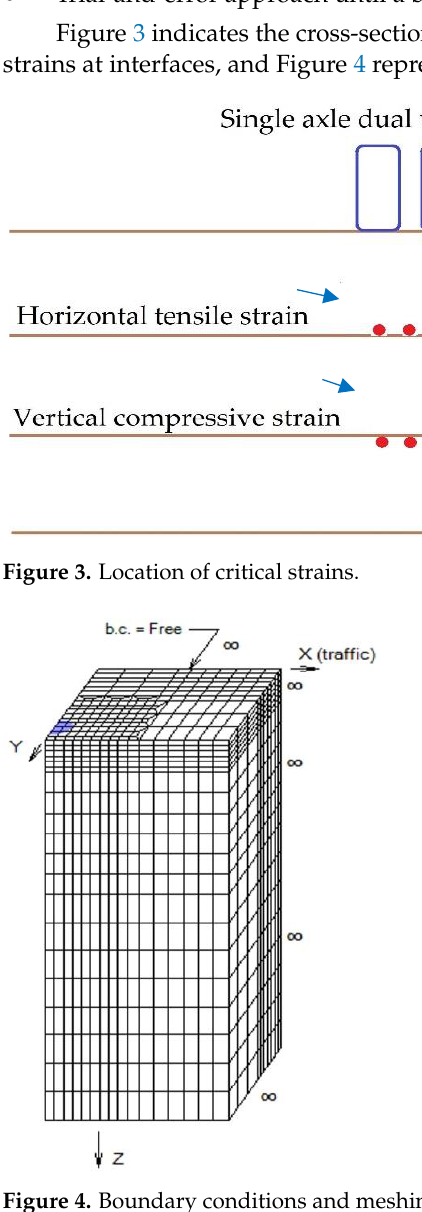
5 of 18 for the design. The wide array of traffic intensities was selected so as to interpret the effect